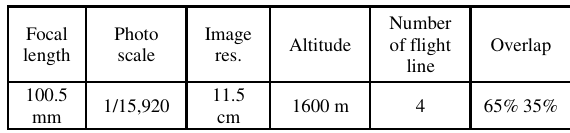
Table 1. Boresight calibration flight